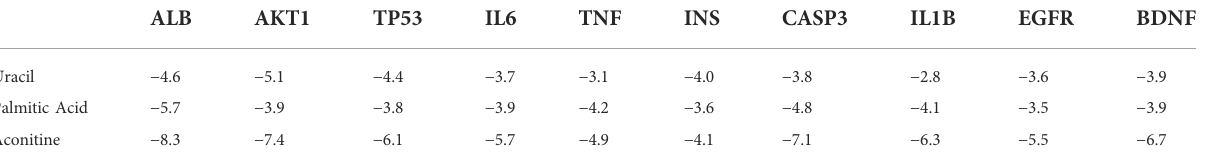
TABLE 3 The binding energy between key toxic substances and core targets of